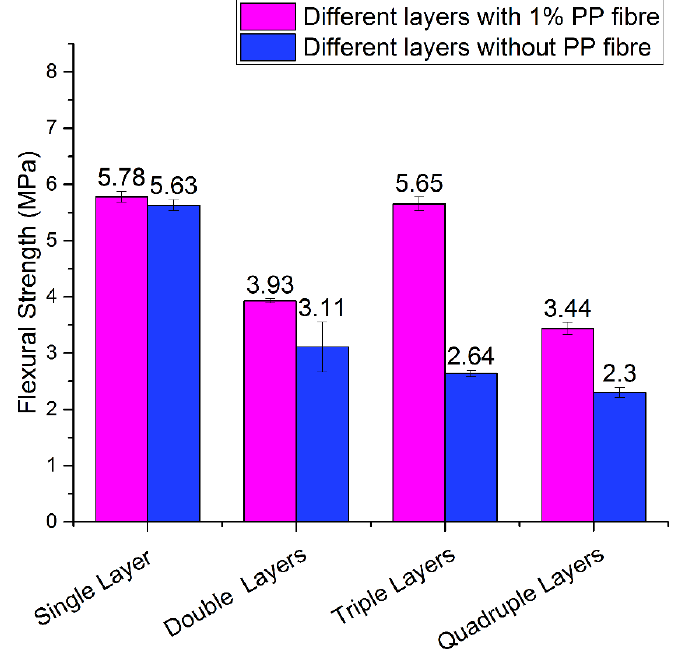
Figure 21. Flexural strength for the (1,2,3,4) layers of mortar mix with 1% PP fibre and without fibre for a circular nozzle of 14 mm after 28 days stored in controlled laboratories at the desired temperature.